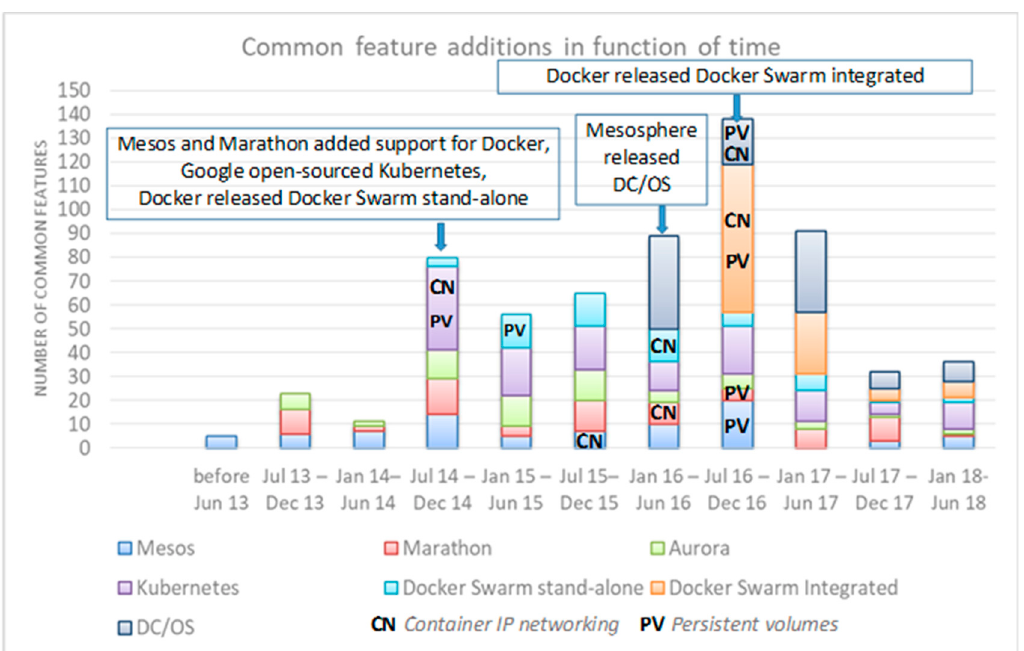
Figure 1. Density of feature additions over time (common features only).